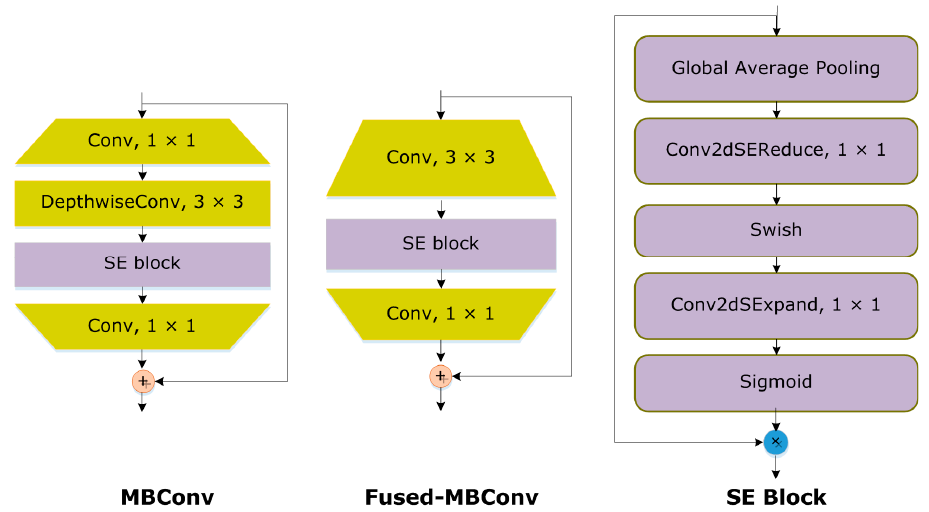
Figure 2. Graphic form of MBConv4, Fused-MBConv4, and SE block. ReLU activation (ReLUAF) is replaced in the framework by the swish activation func- tion ( SAF ) [47], as ReLU excludes values lower than zero and loses an essential component of the used ECG signal. The following equation can be used to calculate the SAF (1):